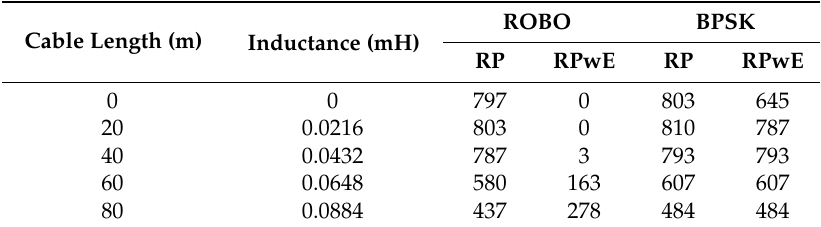
Table 9. ROBO and BPSK Modulations: Lengthening the distance between the transmitting modem and the